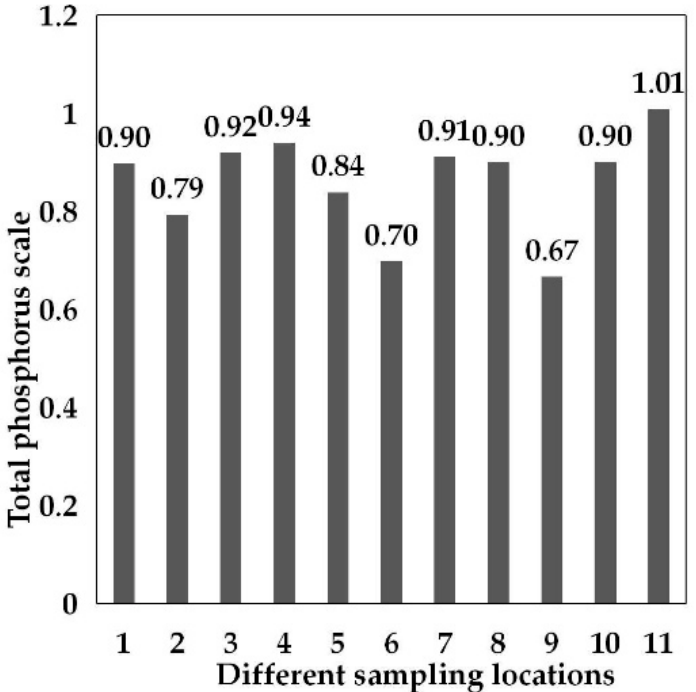
Figure 11. Fixed scale of pollutant phosphorus rate at different sampling points.